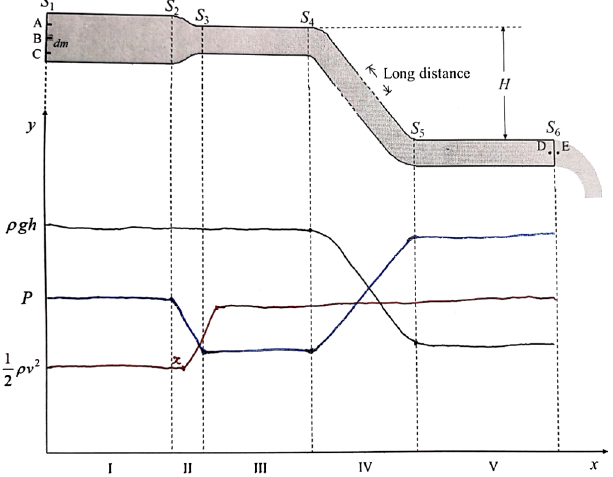
ρ v 2 , ρ gh , and P as a function of horizontal FIG. 5. A graph of 1 2 position x drawn by a teacher participant